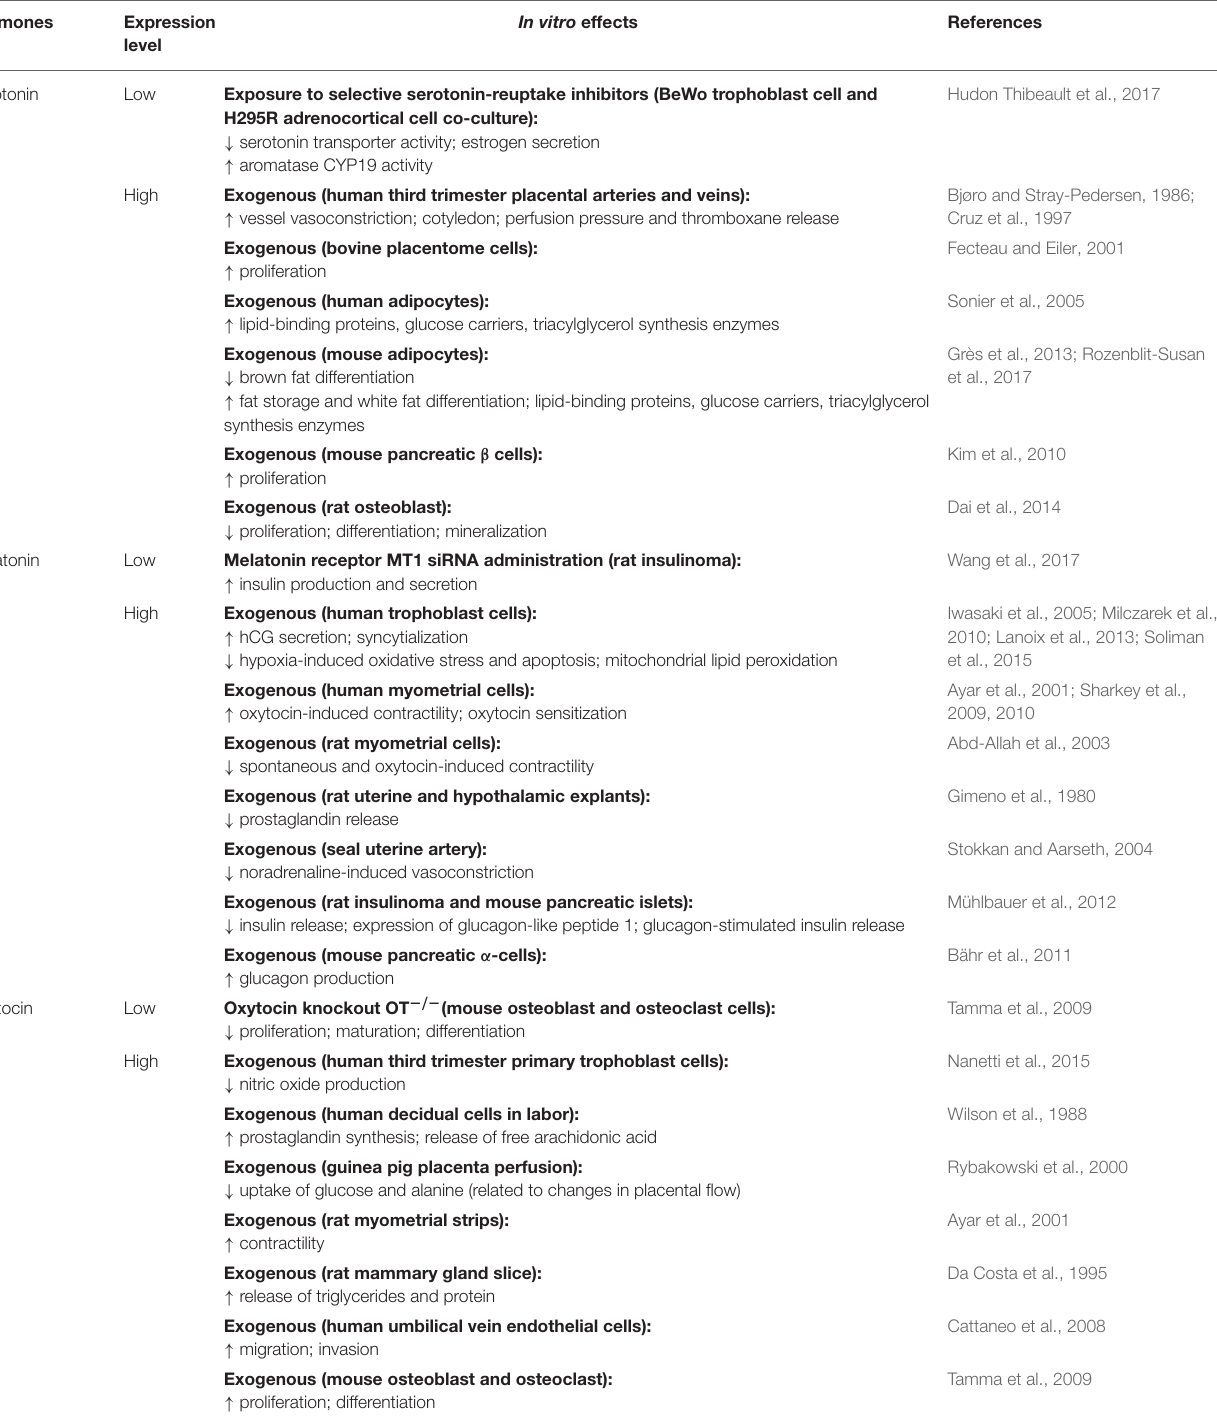
TABLE 6 | Effects of neuropeptides in vitro